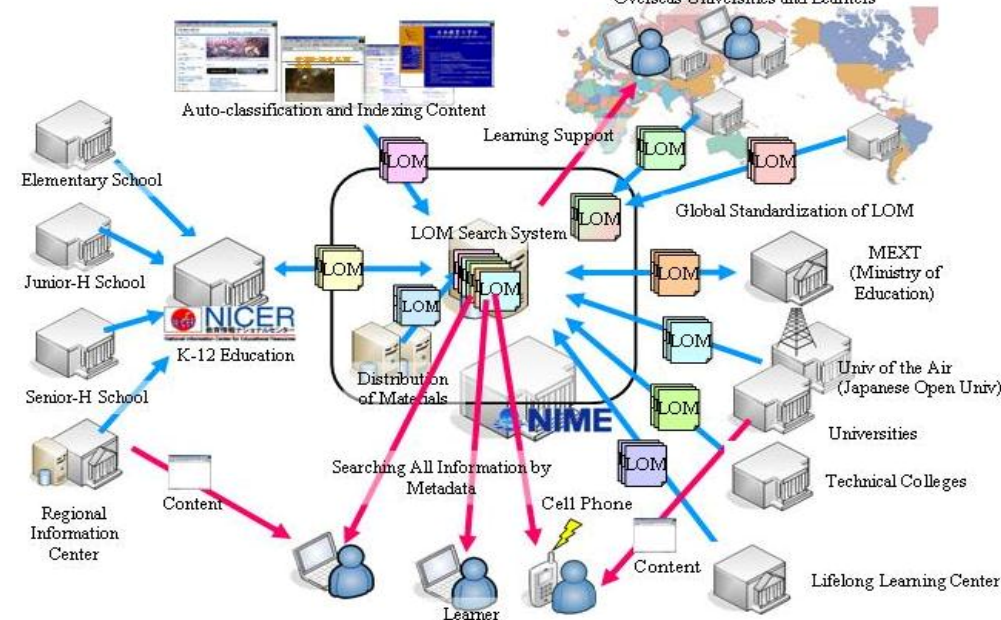
Figure 1. Grand design of “NIME-glad (Gateway to Learning for Ability Development)” (cf. NIME handbook, 2004-2008)